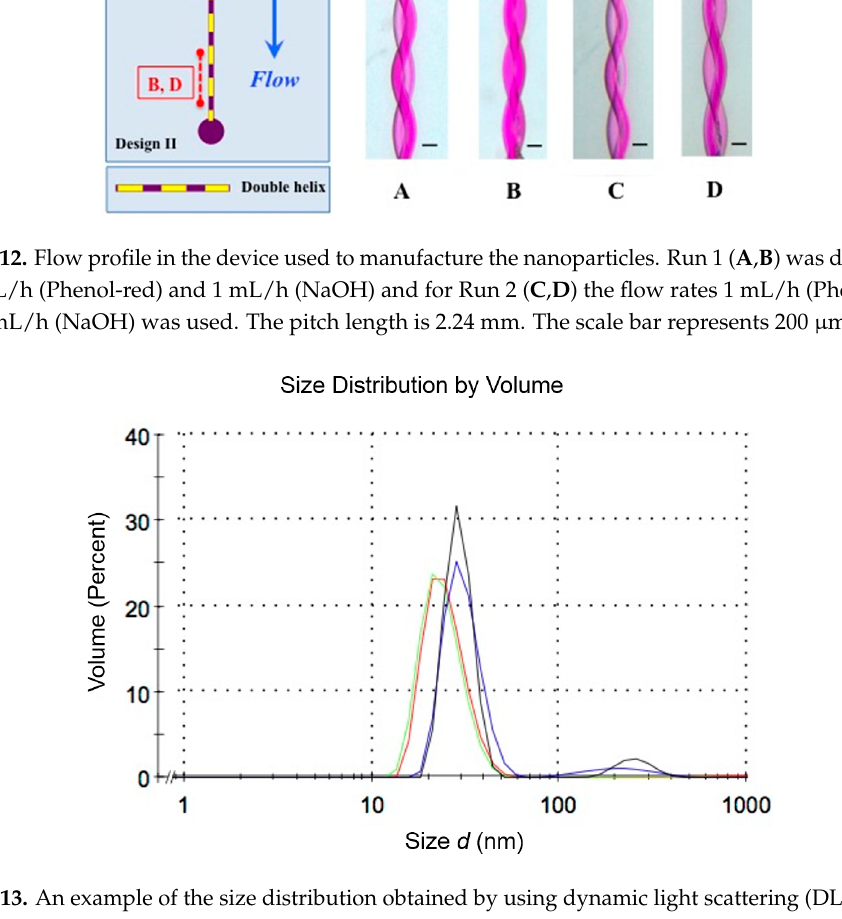
Figure 13. An example of the size distribution obtained by using dynamic light scattering (DLS) on the samples collected in the runs done. In all samples, nanoparticles with a diameter of 24–30 nm were obtained. Each color represents the run of one sample collected (Run 1 (flow rate ratio FRR) = 33.3): red and green and Run 2 (FRR = 6.8): black and blue .